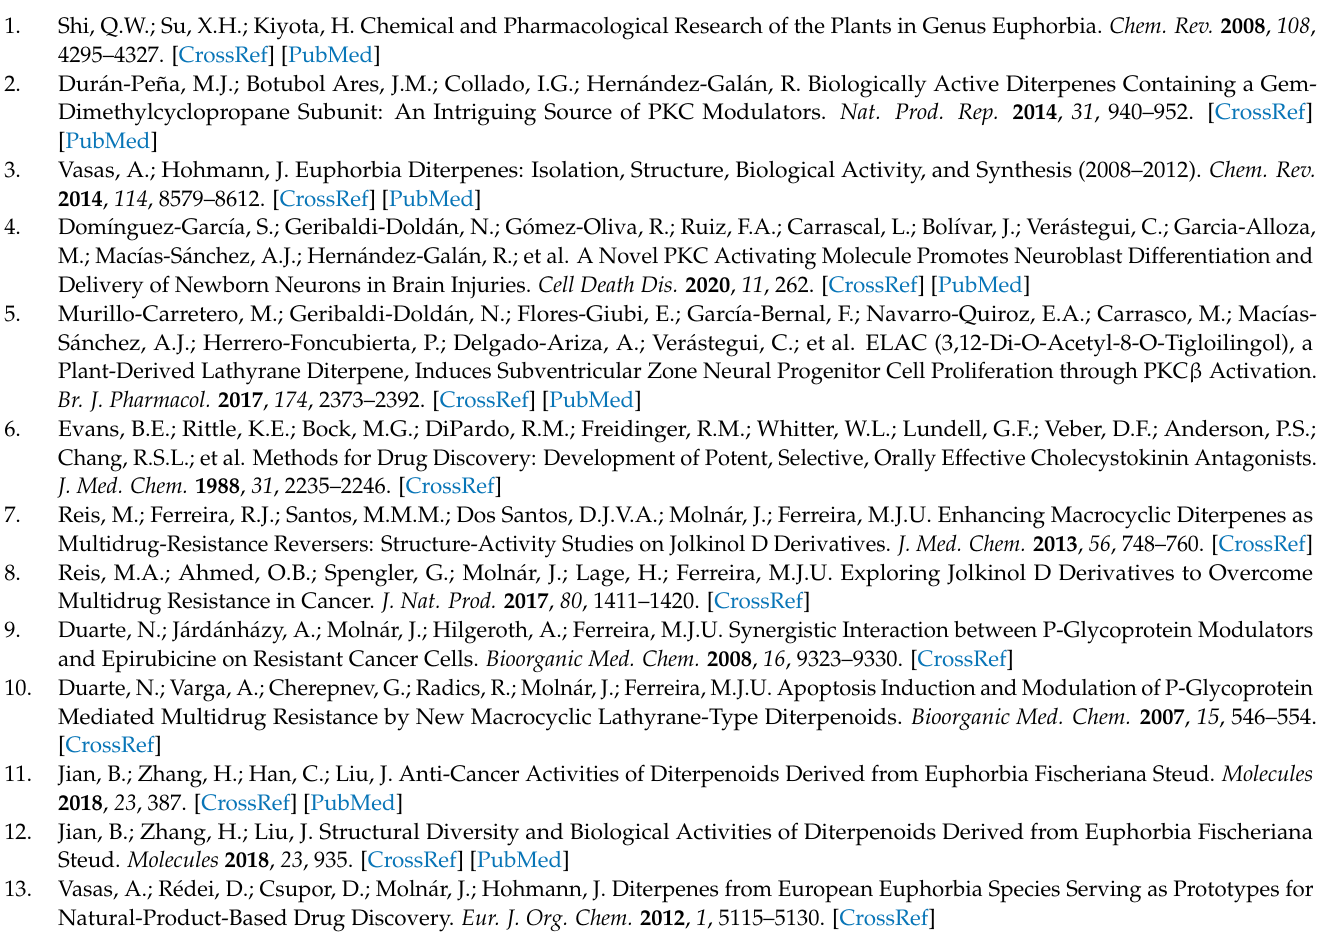
Table S9: Bioactive laurifolioside derivatives: biological activities, observed effects and molecu- lar targets; Section S10: Bioactive jatrogrossidion derivatives; Table S10: Bioactive jatrogrossidion derivatives: biological activities, observed effects and molecular targets; Section S11: Bioactive in- gol derivatives; Table S11: Bioactive ingol derivatives: biological activities, observed effects